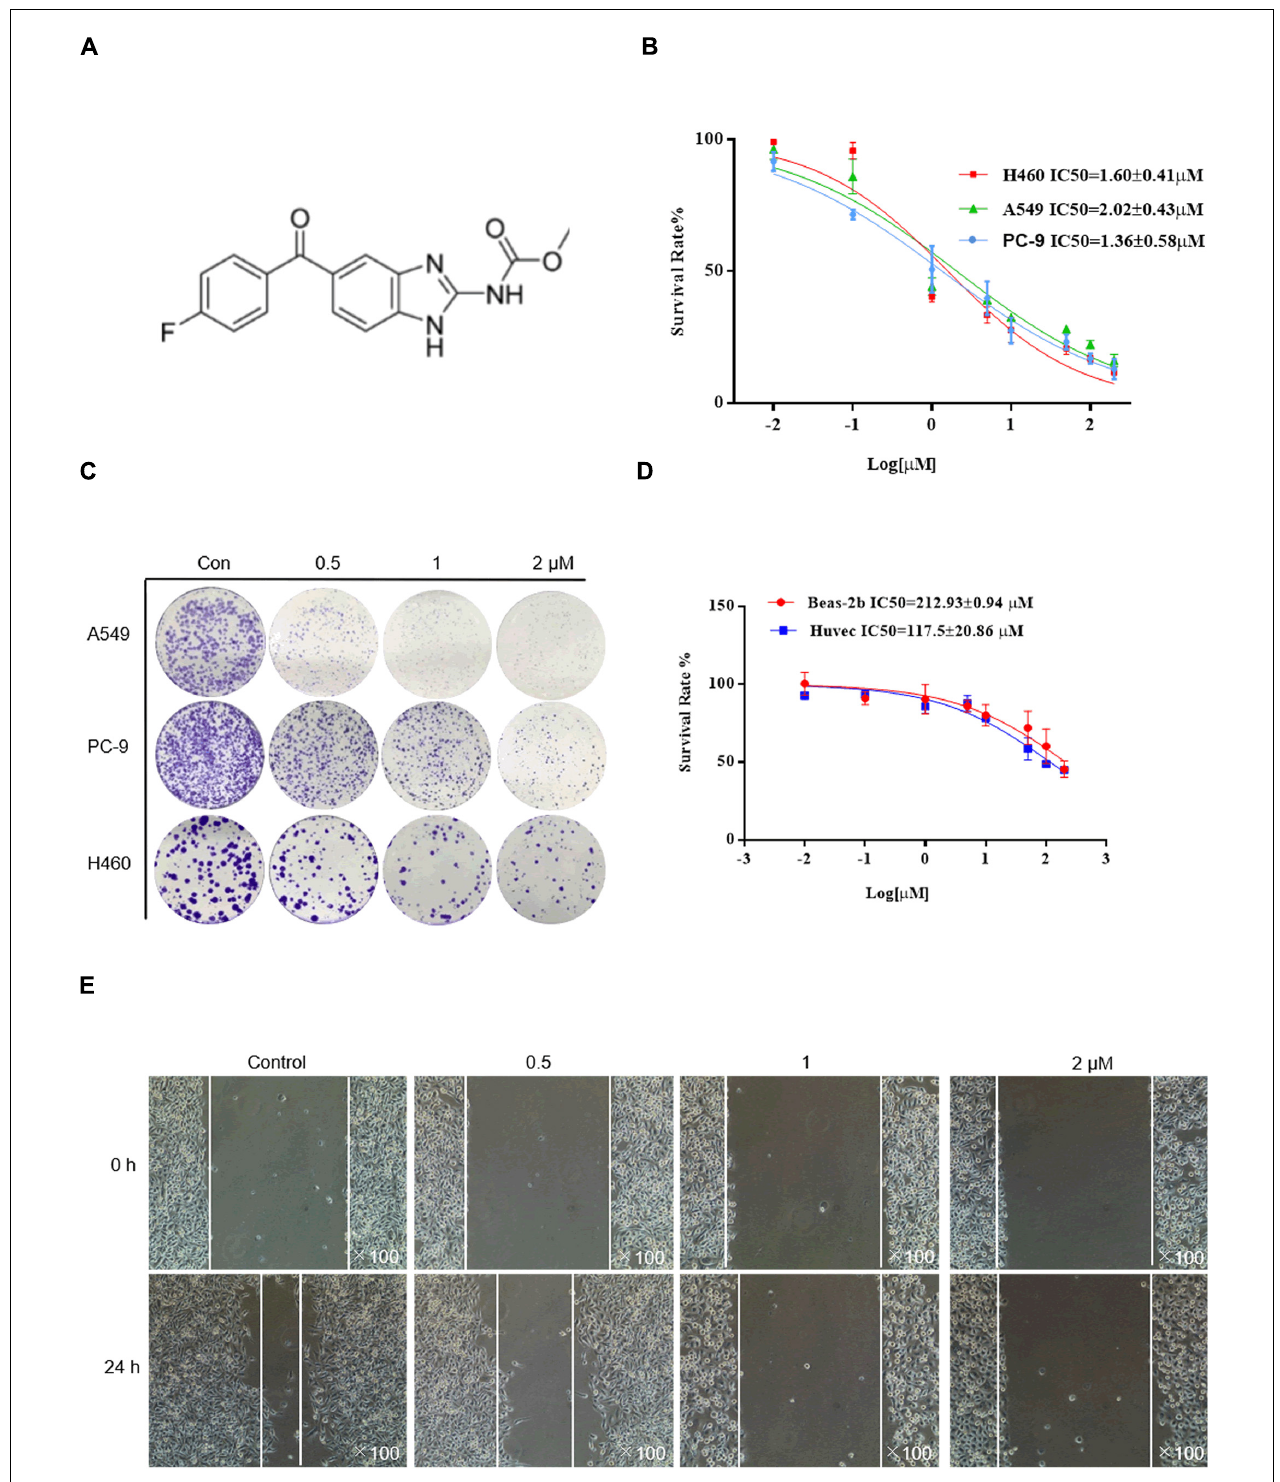
FIGURE 1 | Flubendazole inhibited the viability and migration of lung cancer cells. (A) Chemical structure of flubendazole. (B) IC50 values of flubendazole in NSCLC cells. (C) Inhibitory impacts of flubendazole activity on cell colony formation. (D) IC50 values of flubendazole in HUVECs as well as common human bronchial epithelial cells BEAS-2b. (E) Representative figures of PC-9 cell migration assays. Images shown are representative of three separate experiments.